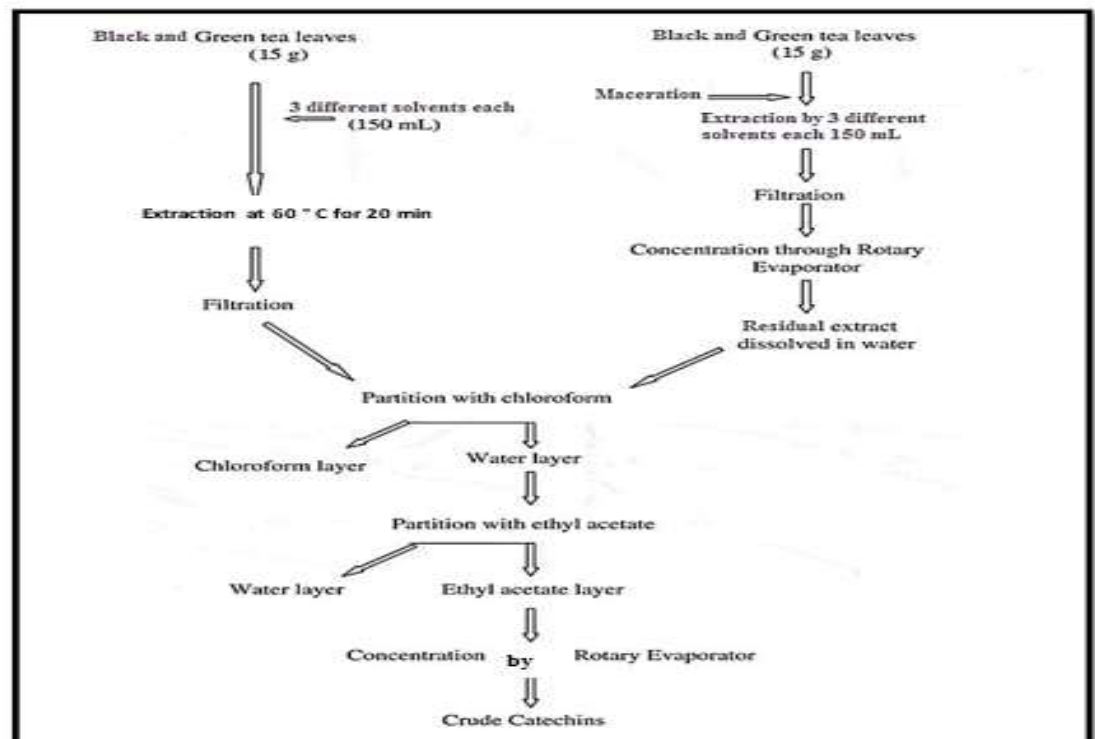
Figure 3. Systematic scheme for extraction of crude catechins